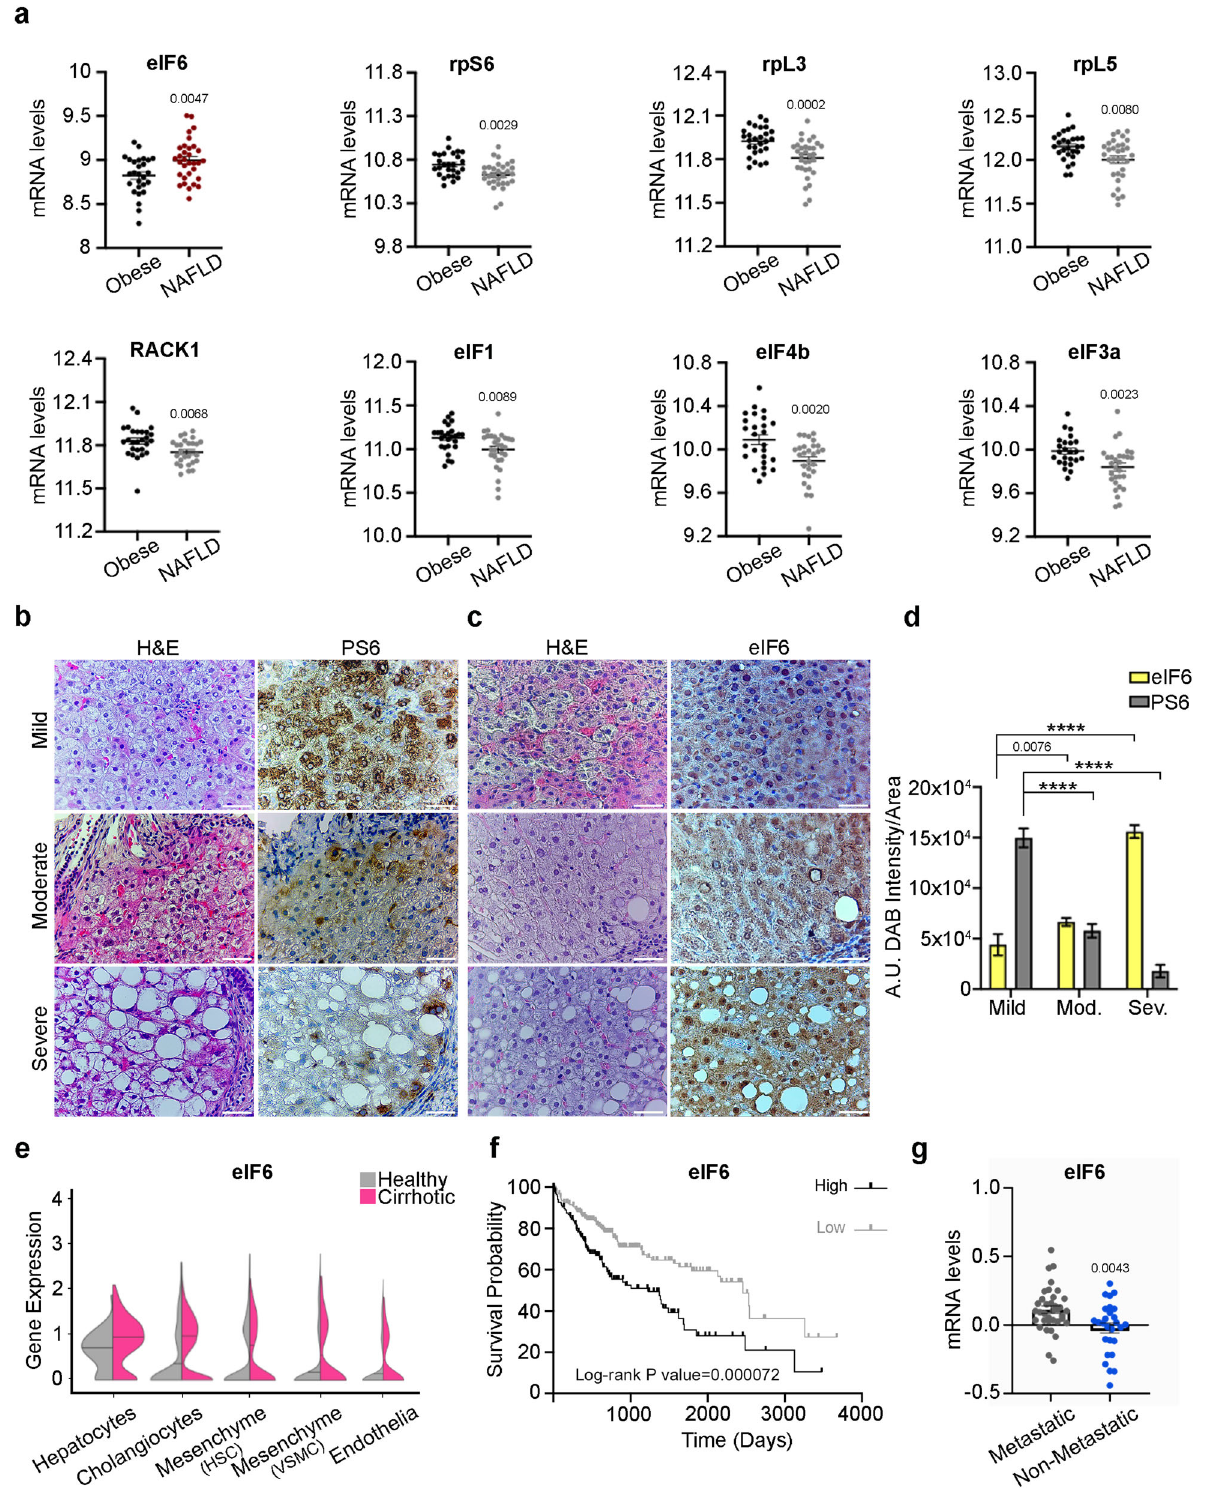
reversible. These data corroborate the hypothesis of a causal relationship between eIF6 dosage, intracellular lipid metabolism, and cellular transformation. We moved to an in vivo model. eIF6 depletion protects from HFD-induced obesity and insulin resistance, and reduces HFD-induced hepatic steatosis and fi brosis progression . We asked whether eIF6 haploinsuf fi ciency